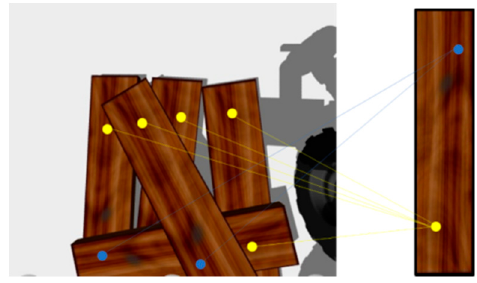
Figure 3. Local image patches matching.